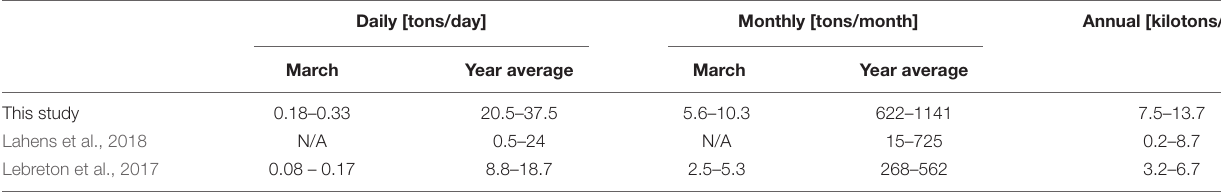
TABLE 1 | Comparison of daily, monthly and annual macroplastic emission